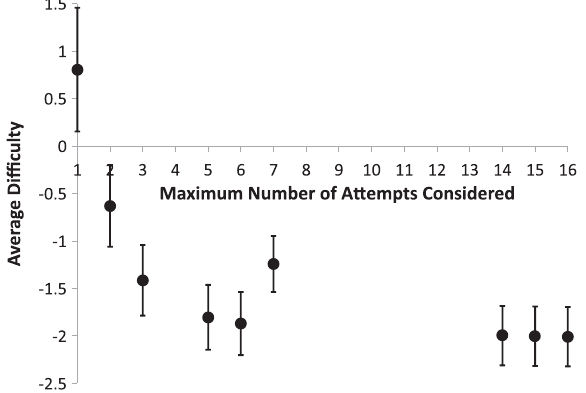
FIG. 5. Log-likelihood of the 2PL IRT analysis of the home- work data as a function of the maximum number N of considered attempts. Missing data points indicate that the fit did not converge. For comparison, without imposing a threshold on the number of attempts, the log-likelihood is − 30070 .